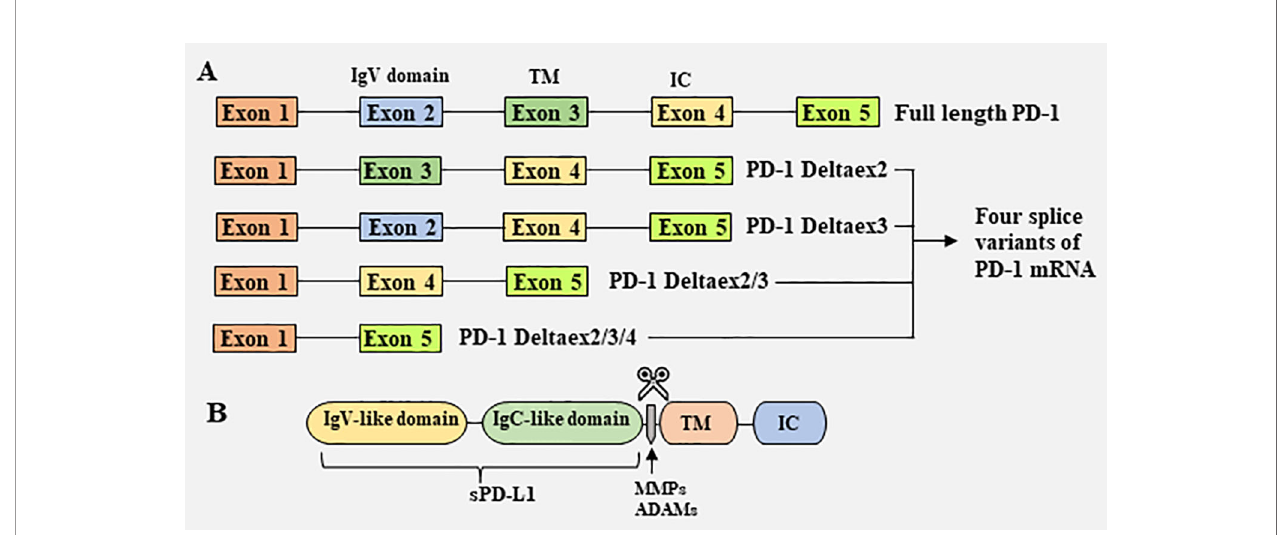
FIGURE 1 | Mechanisms responsible for the generation of soluble PD-1 and PD-L1. (A) Generation of soluble PD-1 from splice variants of PD-1 mRNA. Full length PD-1 ( fl PD-1) mRNA contains fi ve exons (exons 1 – 5), which encode a short signal sequence, an immunoglobulin (Ig) domain, the stalk and transmembrane (TM) domain, a 12 amino acid (aa) sequence that marks the beginning of the cytoplasmic domain, the C-terminal intracellular (IC) domain and a long 3 ’ UTR, respectively. Four splice variants of PD-1 mRNA, PD-1Deltaex2, PD-1Deltaex3, PD-1Deltaex2/3, and PD-1Deltaex2/3/4, have been cloned from human peripheral blood mononuclear cells (PBMCs). PD-1Deltaex3 only lacks exon 3, but retains an extracellular Ig domain. Translation of this mRNA results in a soluble form PD-1. (B) Generation of soluble PD-L1 by proteolytic cleavage of membrane-bound PD-L1. Several proteases, including MMPs and ADAMs, are capable of cleaving membrane-bound PD-L1, releasing soluble